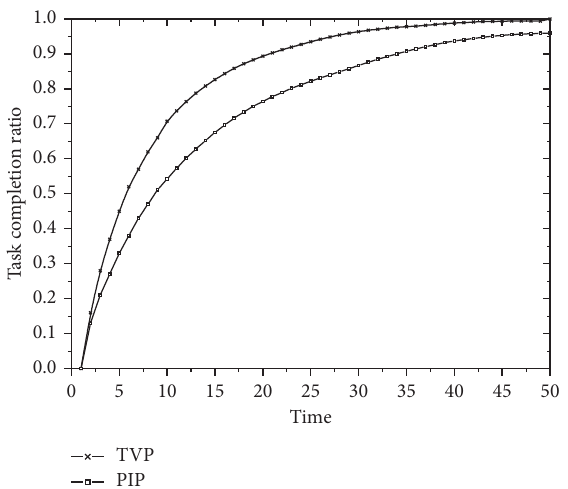
Figure 3: Task type where utility is inversely proportional to task